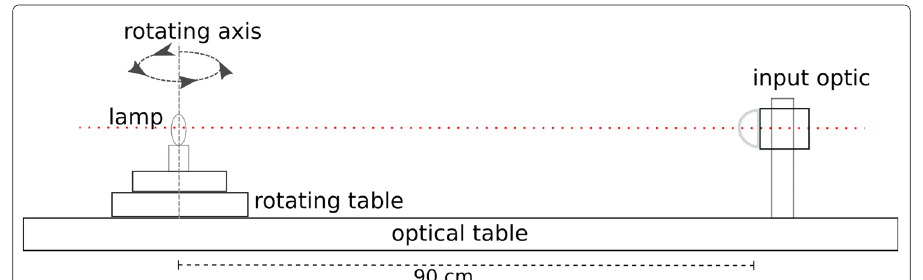
Fig. 8 Optical setup for measuring the distribution of the 100 W lamp emissions on a horizontal plane. The lamp was mounted on a small rotating table. The entrance optics was fixed on the optical table at a distance of 90 cm